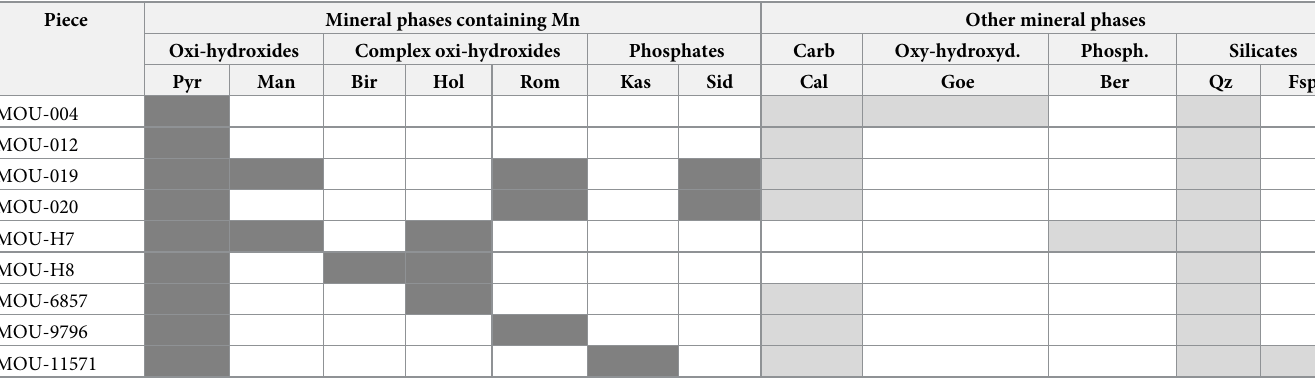
Table 3. Results of XRD analyses of Mn-rich lumps from Le Moustier